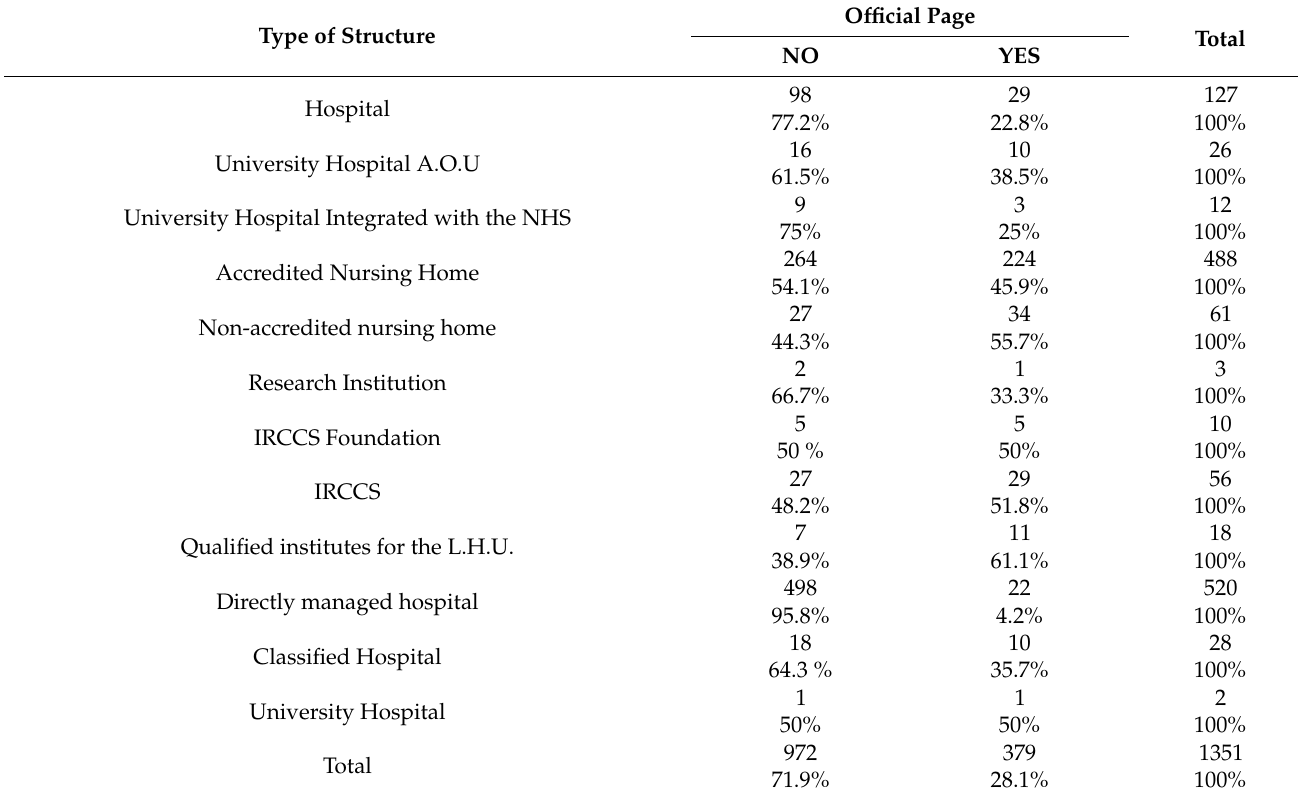
Table 2. Association between the type of hospital and whether they have an official page. Type of